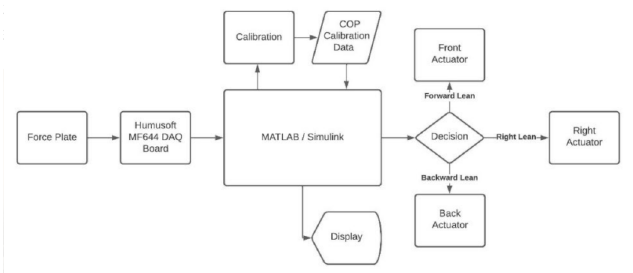
Figure 4. A flowchart that represents the control algorithm of the proposed biofeedback